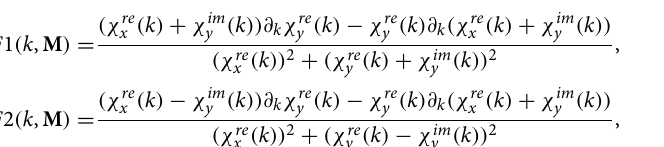
( k )) are given by χ im y ±